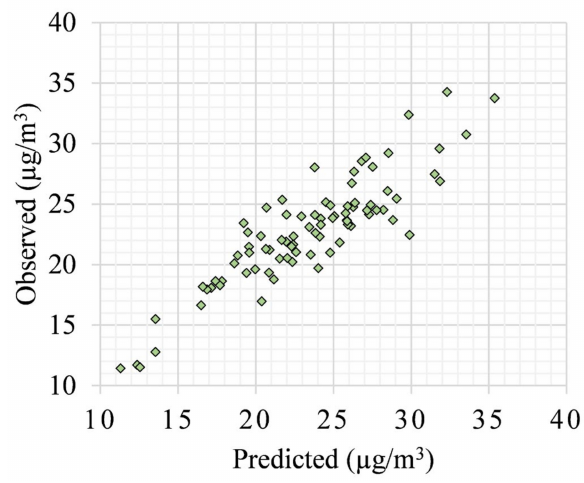
Figure 8. Scatterplot of observed ( y -axis) and estimated ( x -axis) PM 2.5 concentration. The PM 2.5 estimation model developed by using land use information from the geographic and satellite im- age datasets.